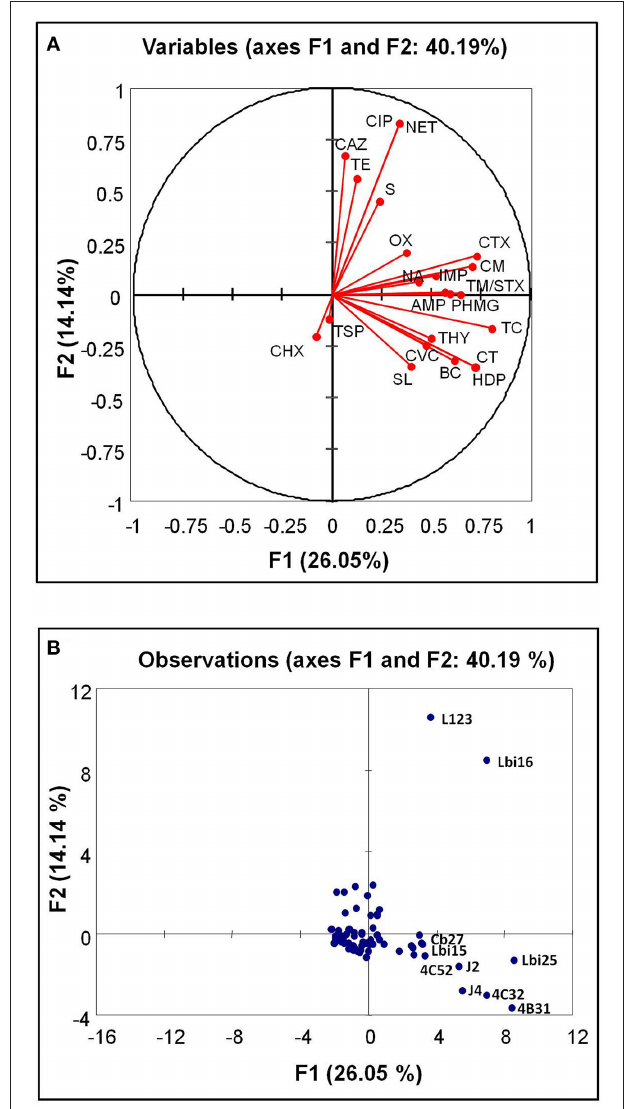
FIGURE 1 | Biplot for biocide tolerance and antimicrobial resistance (scores) in the 87 bacterial isolates (variables) from seafoods. Antimicrobials (A) , red dots, and isolates (B) , blue dots are indicated. In (B) , the letters indicate the bacterial isolates with an outstanding high number of antimicrobial resistance traits. BC, benzalkonium chloride; CT, cetrimide; HDP, hexadecylpyridinium chloride; TC, triclosan; CF, hexachlorophene; PHMG, poly-(hexamethylen guanidinium) hydrochloride; OX, P3 oxonia; AMP, ampicillin; CTX, cefotaxime; CAZ, ceftazidime; IMP, imipenem; CM, chloramphenicol; S, streptomycin; TE, tetracycline; NA, nalidixic acid; TM/STX, trimethoprim-sulfamethoxazole; CVC, carvacrol; THY, thymol; SL, sodium lactate; TSP, trisodium